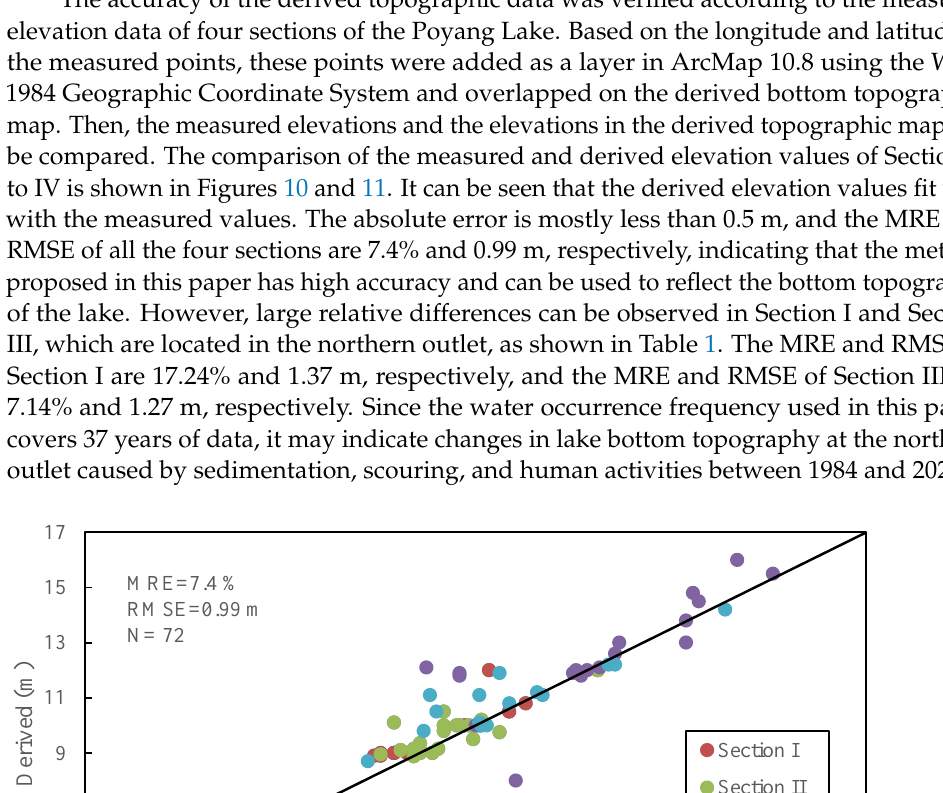
Figure 9. The distribution histogram of Poyang Lake ’ s bottom topography: the black boxes are the percentages for each interval, and the red line is the cumulative percentage.